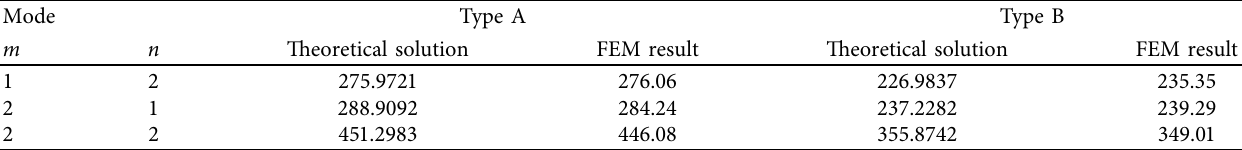
Table 1: Comparison of natural frequencies (Hz).